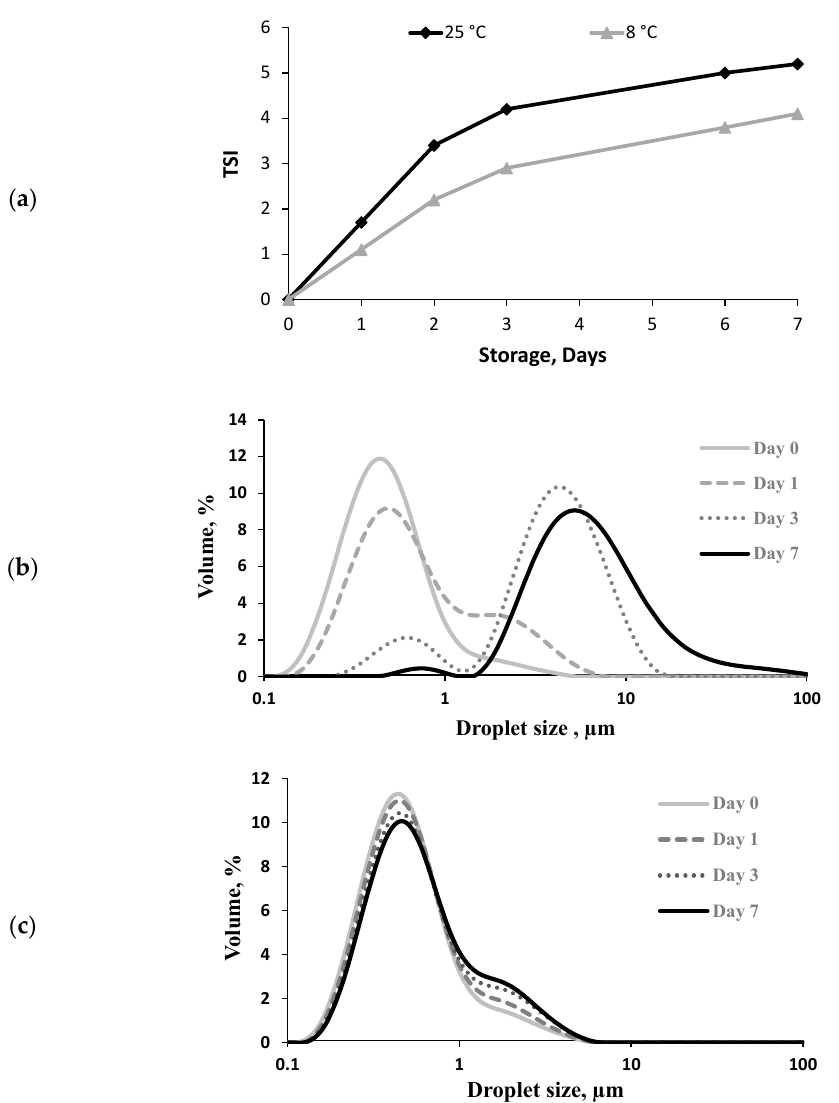
Figure 2. Physical stability of fish oil-in-water emulsion: ( a ) evolution of TSI (Turbiscan Stability Index) during storage at 25 and 8 °C, ( b ) droplet size distribution during 7 days of storage at 25 °C, and ( c ) droplet size distribution during 7 days of storage at 8 °C.